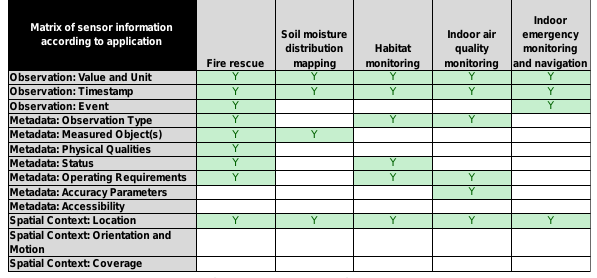
Table 1. Matrix of sensor key information according to